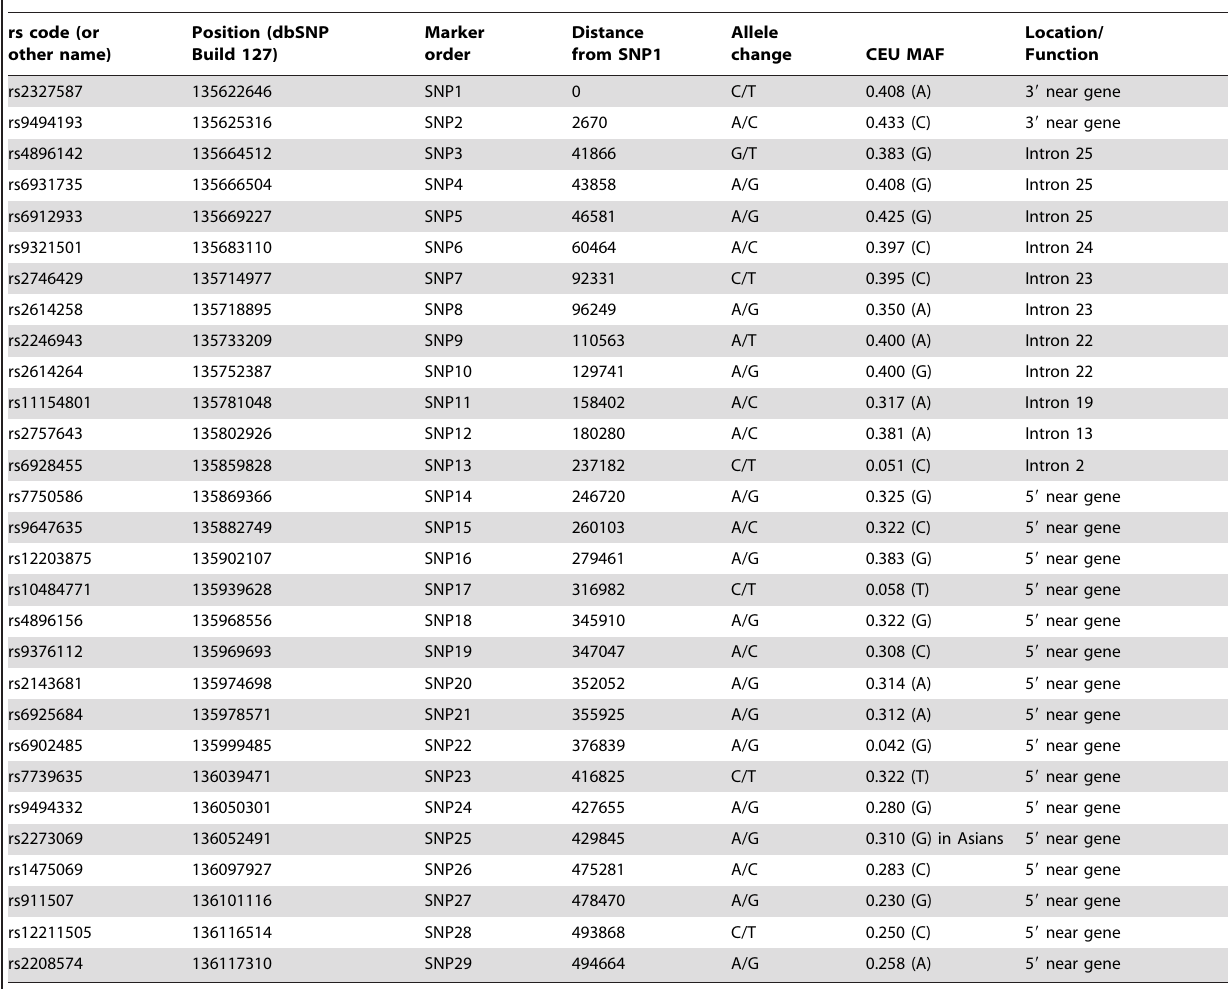
Table 3. List of SNPs included in the present